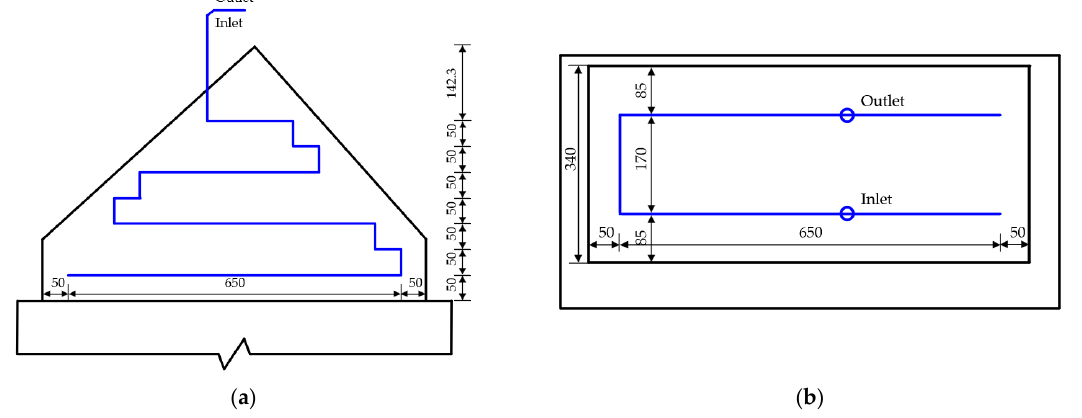
Figure 10. The arrangement of temperature monitoring points for mass concrete in arch abutment: ( a ) elevation; ( b ) Plan. (Unit: cm).